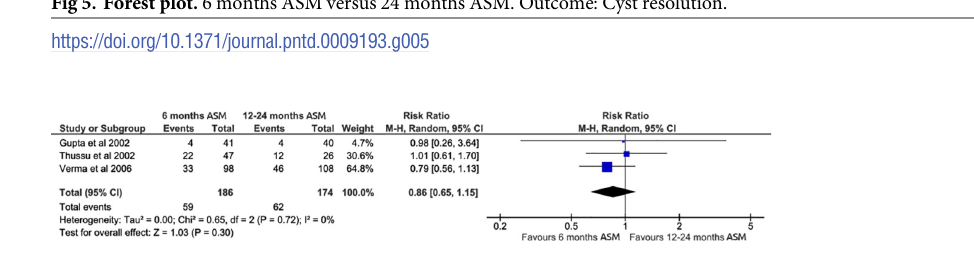
Fig 6. Forest plot. 6 months ASM versus 12–24 months ASM. Outcome: Calcifications.